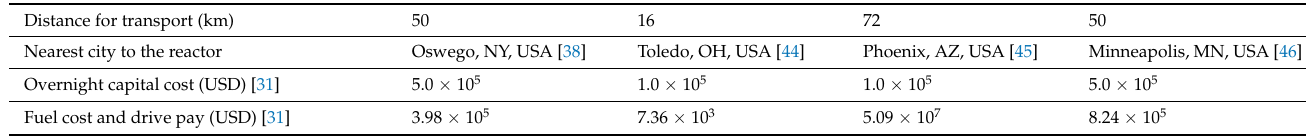
Table 5. Input data for hydrogen transport using